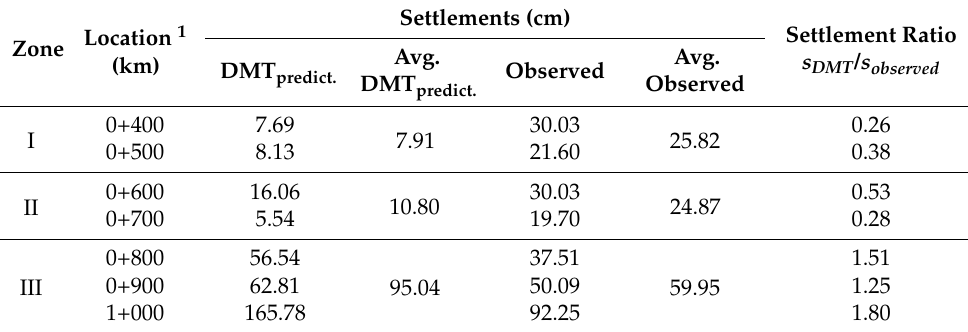
Table 4. Comparison of